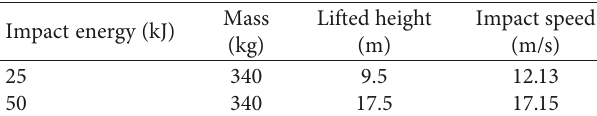
Table 2: Impact parameters of the